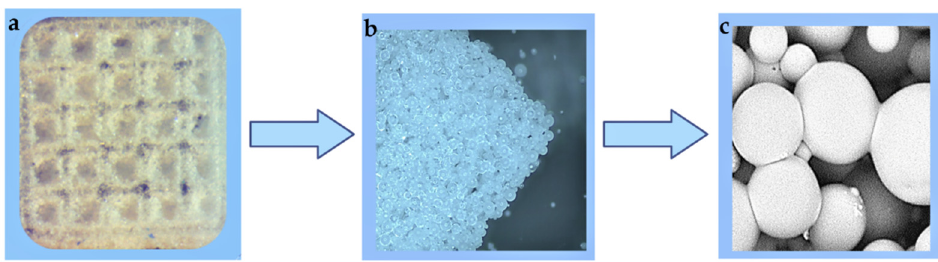
Figure 6. 3D structures fabricated from polylactide microparticles via selective laser sintering: photo of the 3D scaffold ( a ), optical micrograph at higher magnification ( b ) and SEM image of the sintered microparticles ( c ) forming the 3D scaffold. Images of the 3D structures were made by authors.